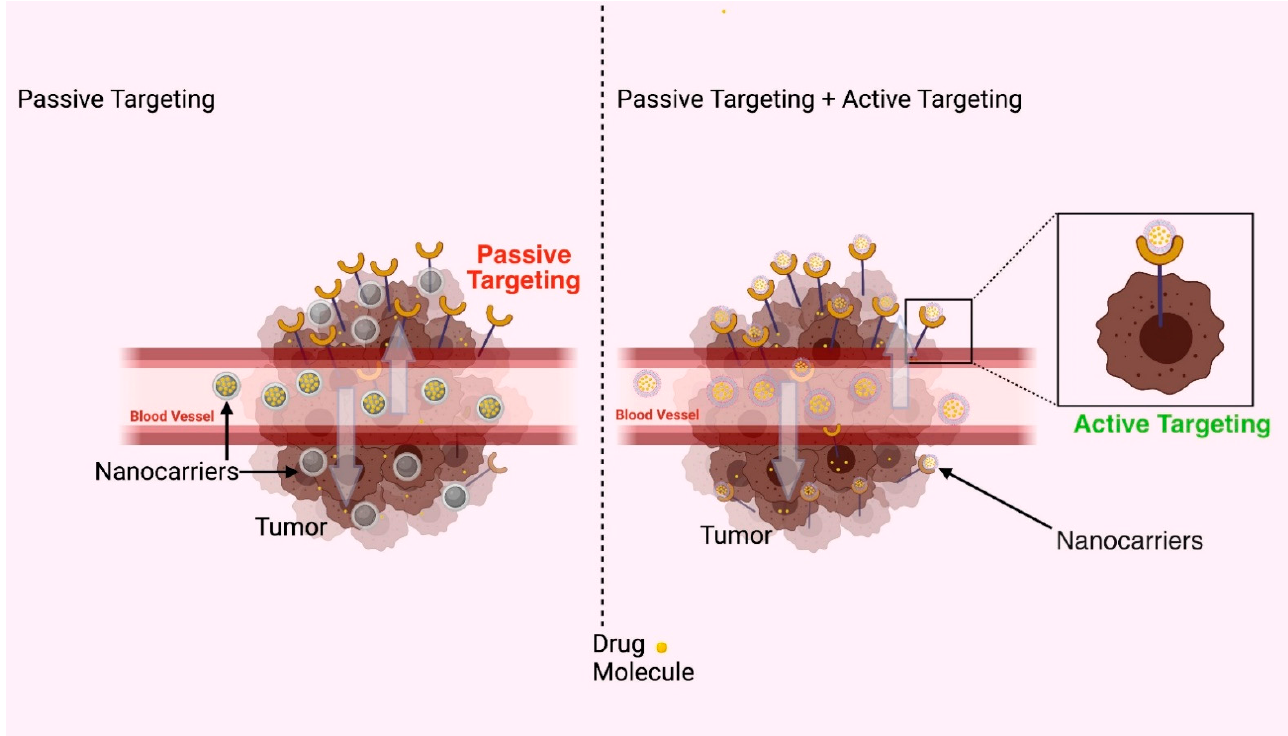
Figure 6. Graphical representation of active and passive targeting of drugs via polymeric nanocar- riers following parenteral administration. following parenteral